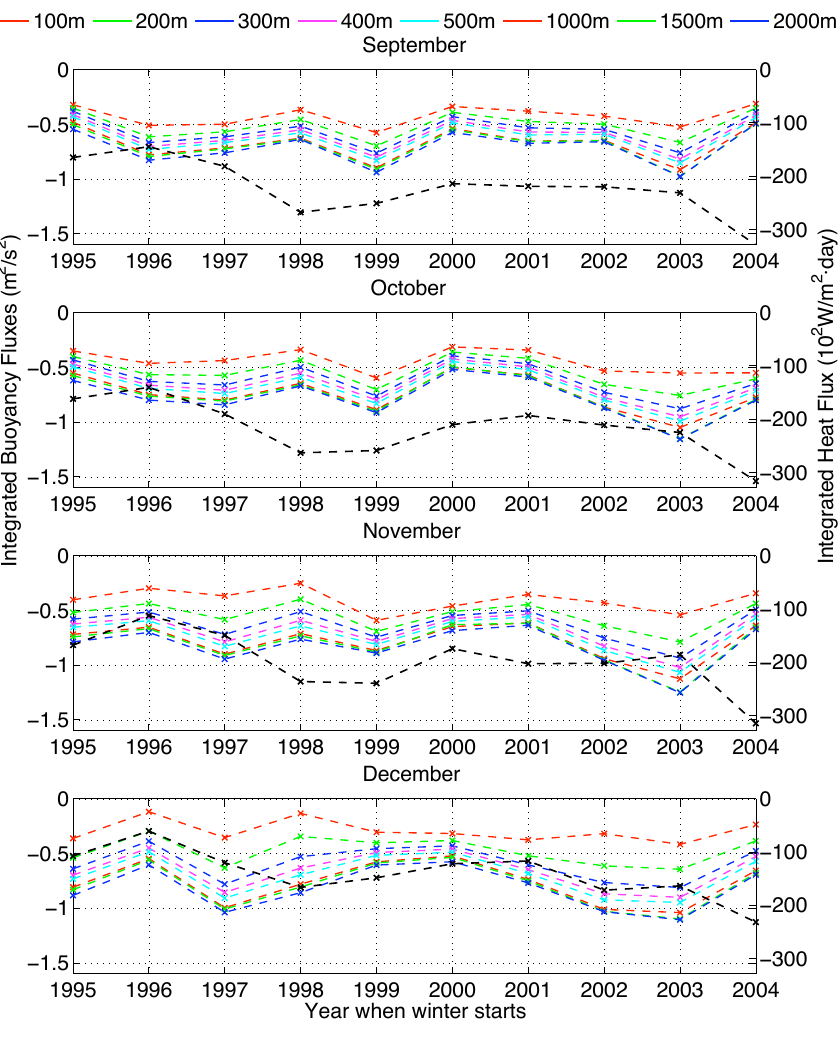
Fig. 9. Buoyancy fluxes that would be necessary to have a convective mixed layer of depth of h and actual integrated buoyancy fluxes (thick black line) for each winter.